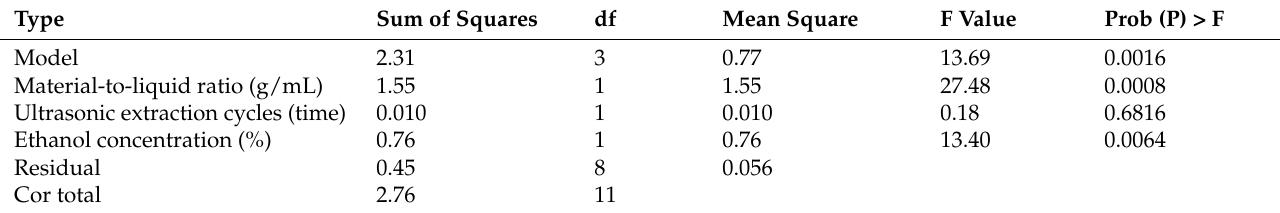
Table 2. ANOVA for the regression quadratic model equation of PBD.